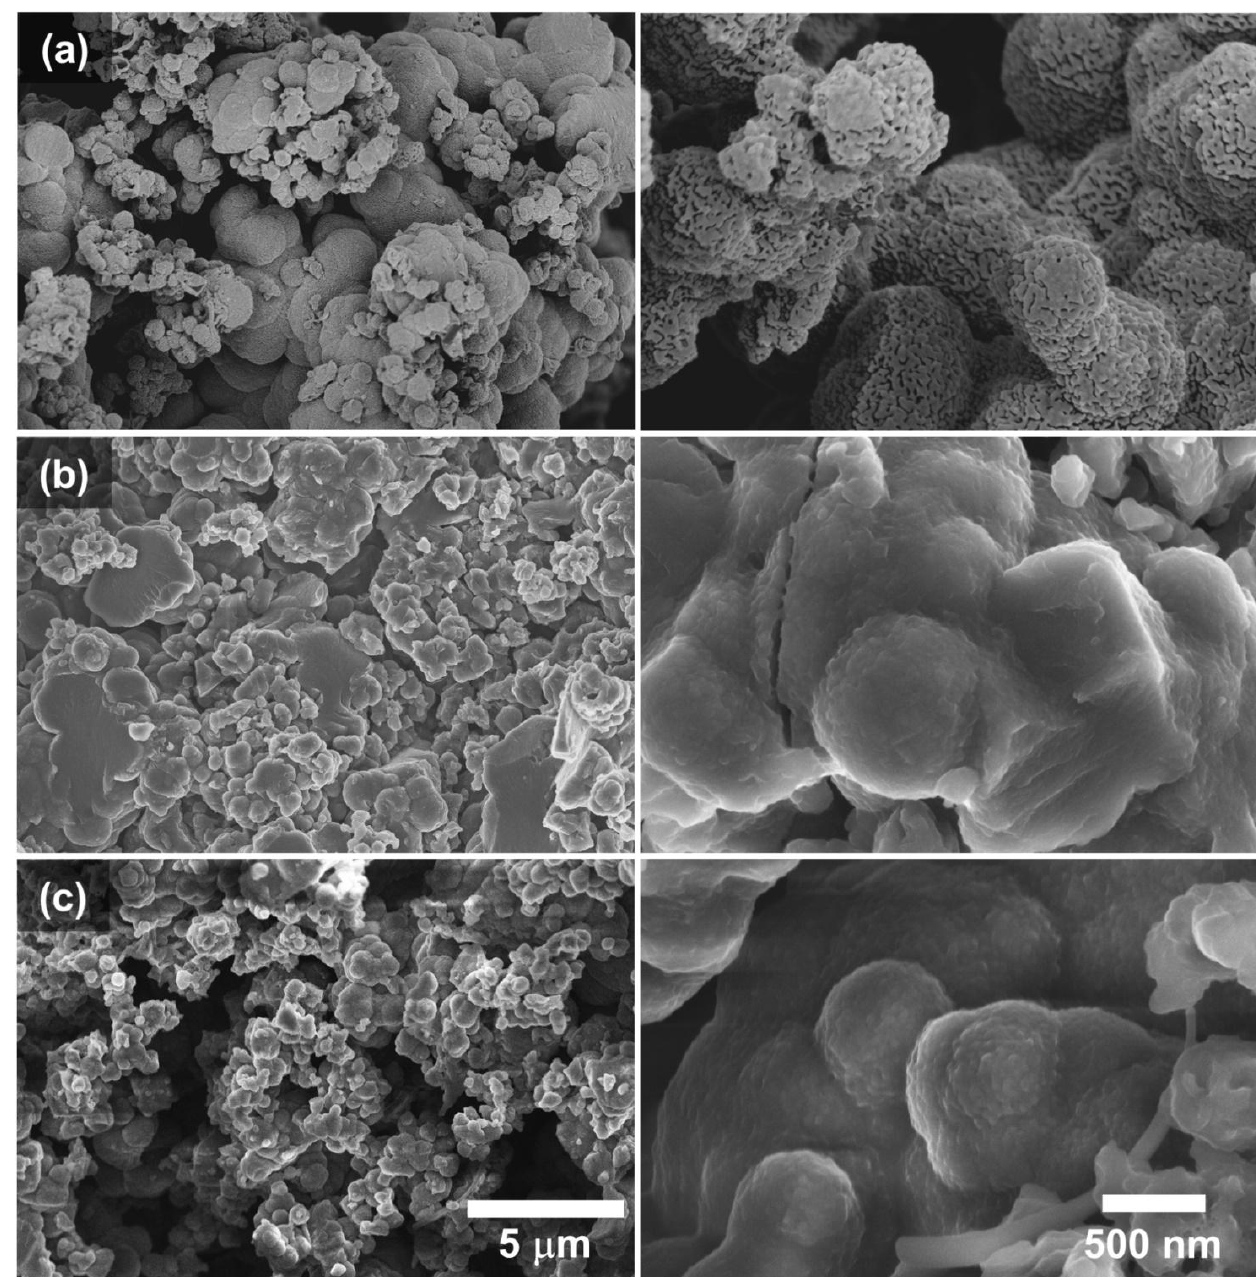
Figure 5. SEM micrographs of the ( a ) untreated and treated samples, ( b ) TT 100 , and ( c ) TT 200 . The magnification is 15,000× and